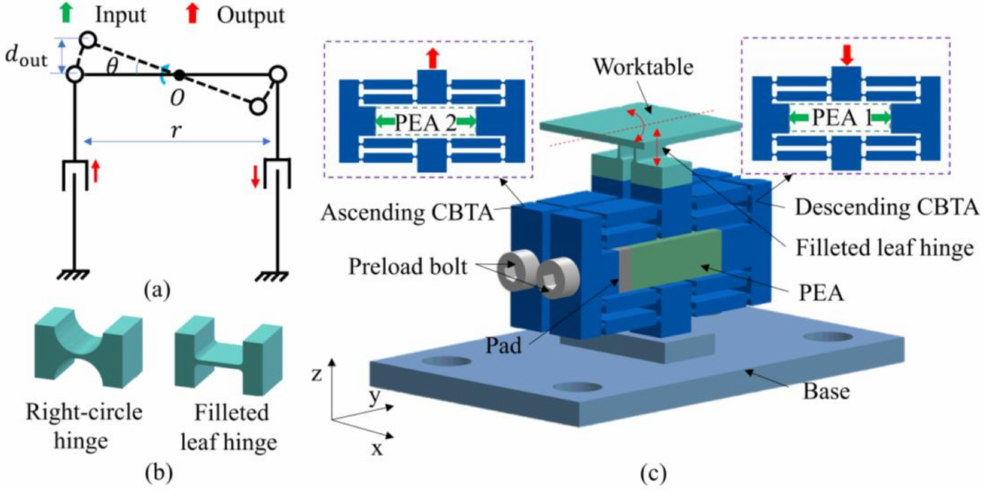
Figure 1. ( a ) Platform topology. ( b ) Flexure hinges. ( c ) 2-DOF ( θ y , Z) positioning